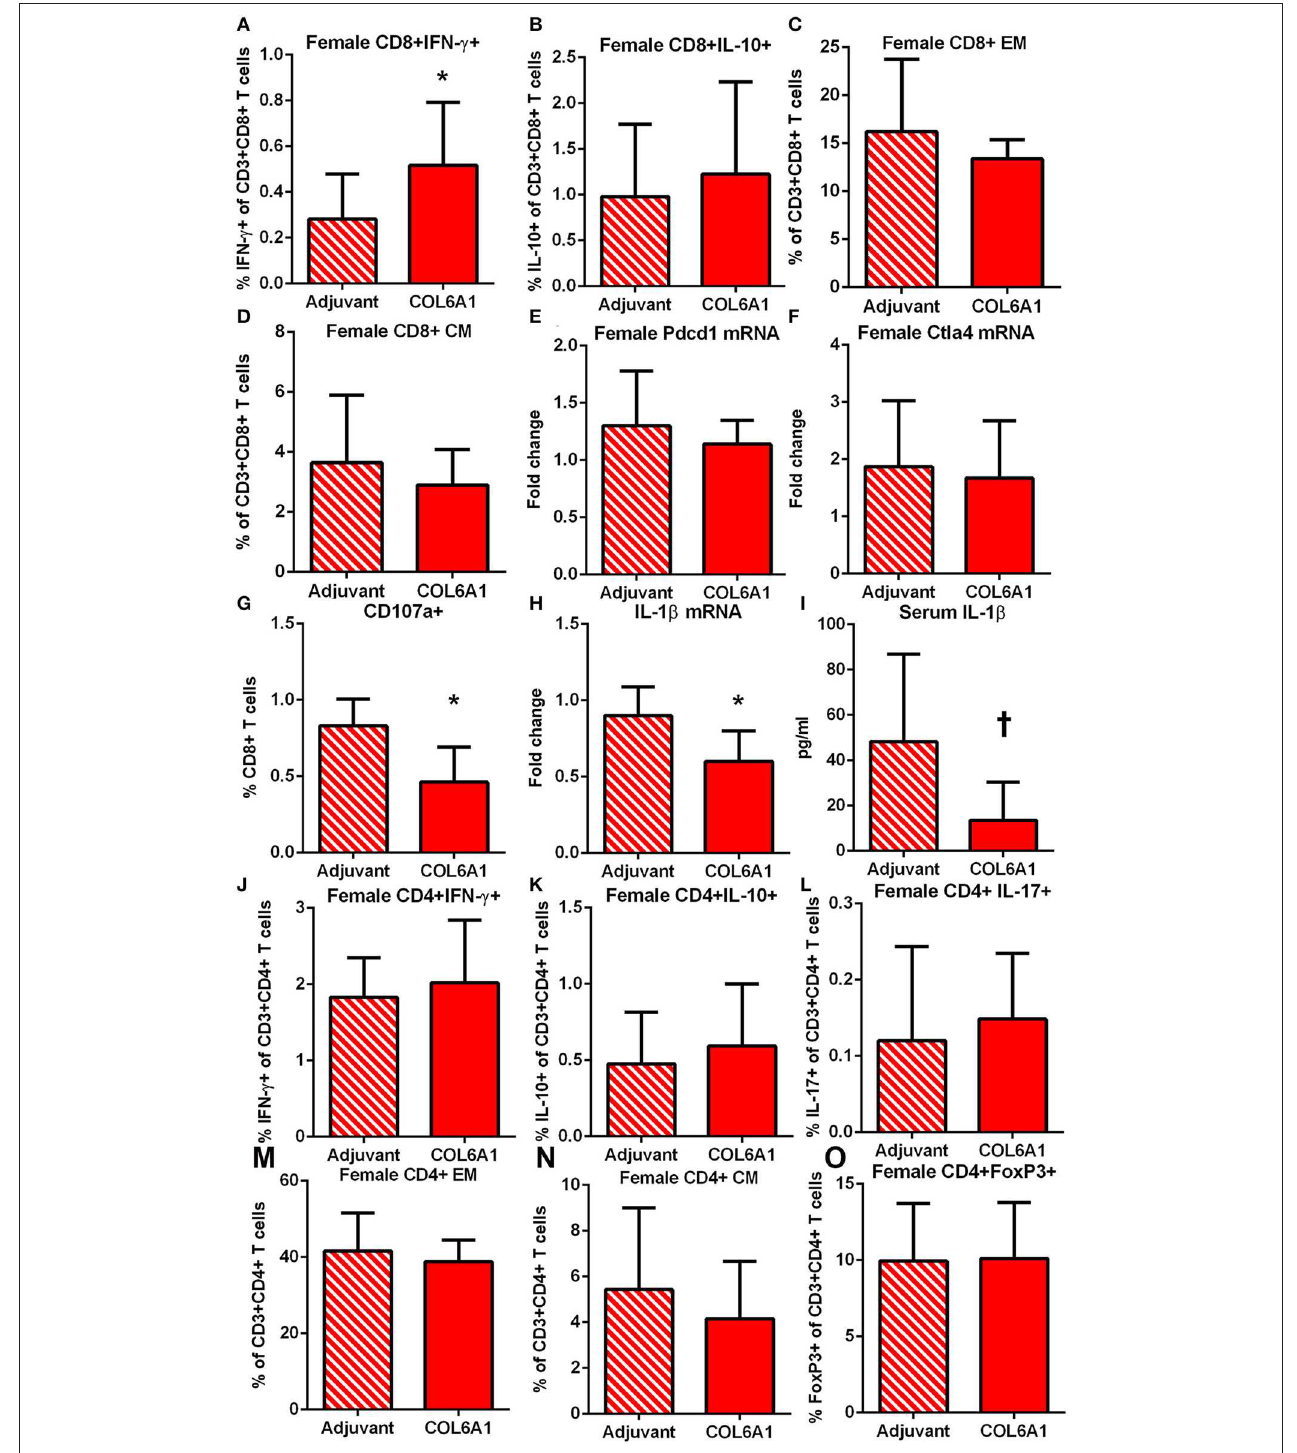
FIGURE 8 | Immune profile of female apoE–/– mice immunized with COL6A1. Intracellular staining of splenocytes from female mice immunized with COL6A1 [ (A,B) ; N = 11 each]. Splenocytes were also stimulated with COL6A1 peptide for 48h and stained for Effector Memory (EM) and Central Memory (CM) CD8 + T cells [ (C,D) , respectively; N = 6–7 each]. Pdcd1 and Ctla4 mRNA expression in spleens [ (E,F) ; N = 5 each]. Cytolytic activity of CD8 + T cells assessed by CD107a stain in splenocytes of female mice after 5h stimulation with COL6A1 peptide [ (G) ; N = 4–5 each]. IL-1 β mRNA expression in spleens [ (H) ; N = 5 each] and serum IL-1 β [ (I) ; N = 5 each]. * P < 0.05, † P = 0.055. Intracellular staining of CD4 + T cell (J–L) , EM and CM CD4 + T cells [ (M,N) , respectively], and CD4 + FoxP3 + T cells (O) . Gating schemes for flow cytometric analysis as depicted in Figure S1 for cytokine stain, Figure S2 for Memory cells, Figure S3 for CD107a, and Figure S4 for CD4 + IL-17 + T